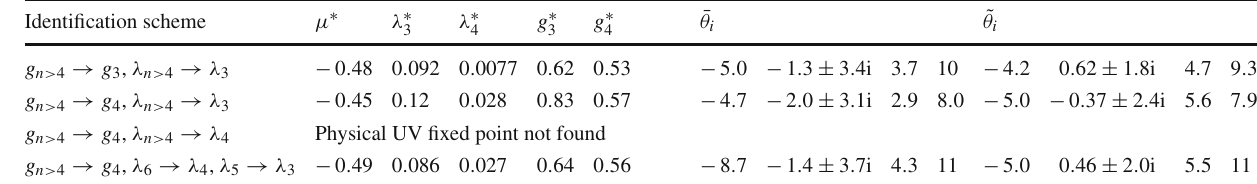
Table 2 Properties of the non-trivial UV fixed point for different iden- schemes with mildly varying fixed point values. In the first approxima- tion of the stability matrix we always find three attractive directions, tification schemes, i.e. different closures of the flow equations, as dis- while in the second approximation of the stability matrix we find one cussed in Appendix 1. The flow equations are computed with momen- or three attractive directions, since the real part of one complex pair of tumdependentanomalousdimensions η φ andbilocallyprojectedNew- i eigenvalues is quite close to zero. These results suggest that the present ton’s couplings g n ( k 2 ) . The critical exponents ¯ θ i and ˜ θ i stem from systemisratherstableunderchangeoftheclosureoftheflowequations. two different approximation of the stability matrix as discussed in In the case of the single identification without a physical UV fixed point Appendix 1. An attractive UV fixed point is found in most identification we found that it had in fact just vanished in the complex plane